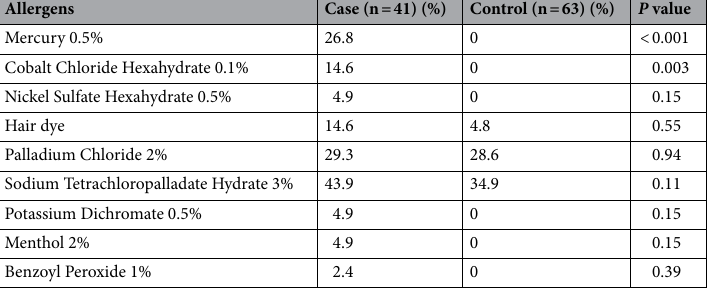
Table 1. Patch test results. Analysis were done with Chi-square test (or Fisher exact test if appropriate).